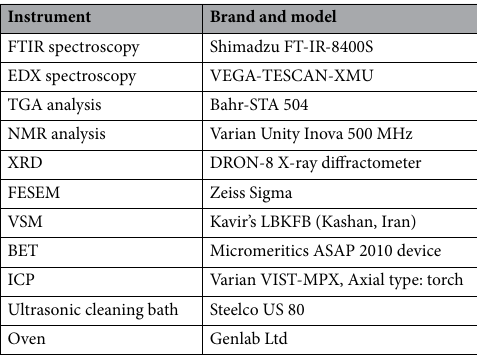
Table 5. The name and model of the used equipment in the current